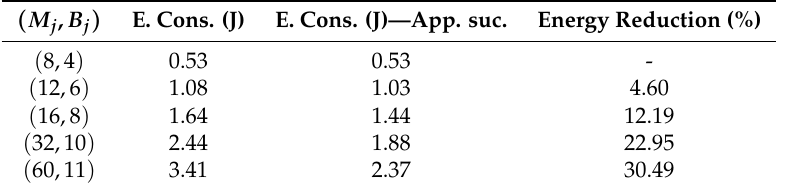
Table 3. Evaluation of the proposed successive approximation scheme capability to save sensor nodes energy—Scenario 1.